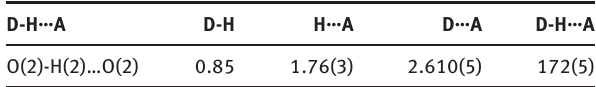
Table 1 Hydrogen bond geometry ( Å , ° PhPO H] . 3 3 n